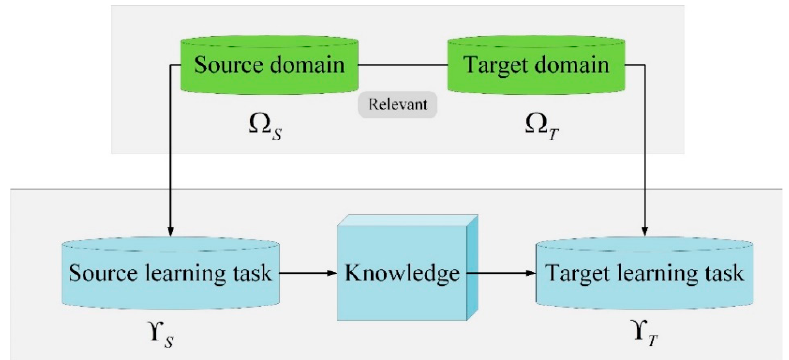
Figure 1. Schematic diagram of transfer learning.